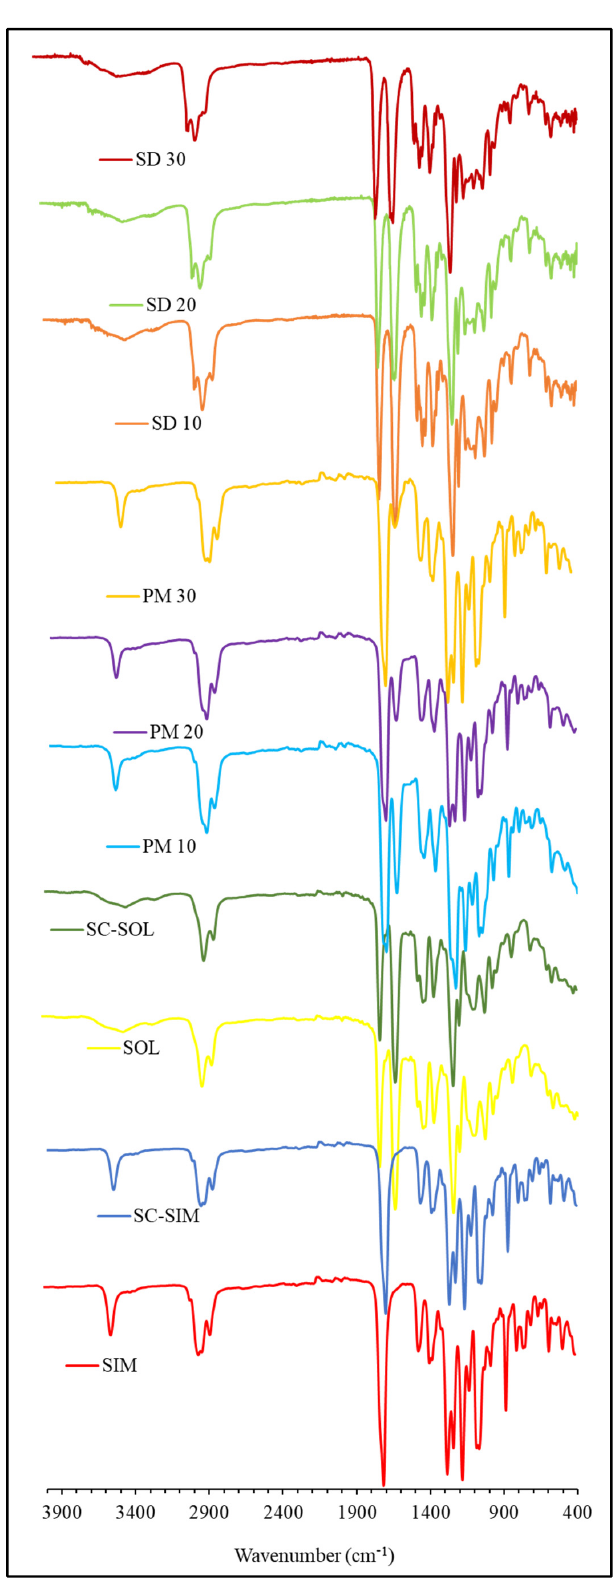
Figure 4. ATR-FTIR spectra of Soluplus ® , Simvastatin, physical mixture (PM10, PM20, and PM30 and solid dispersions (SD10, SD20, and SD30) prepared at 50 °C and 150 bar.